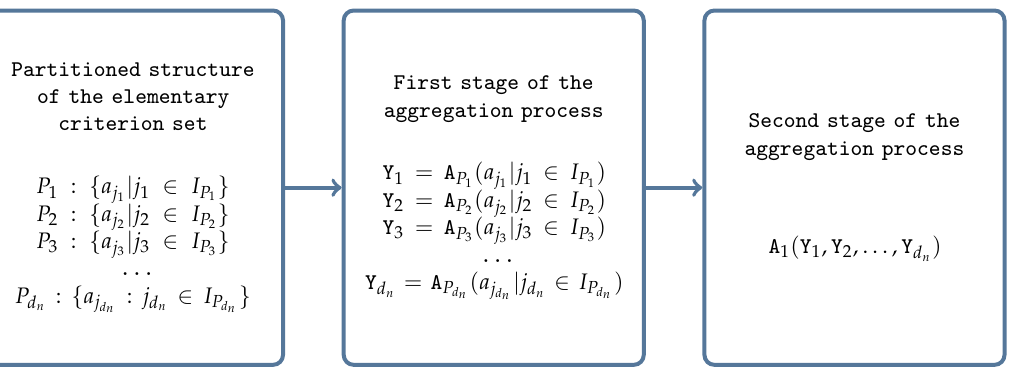
Figure 2. Aggregation process of hierarchical